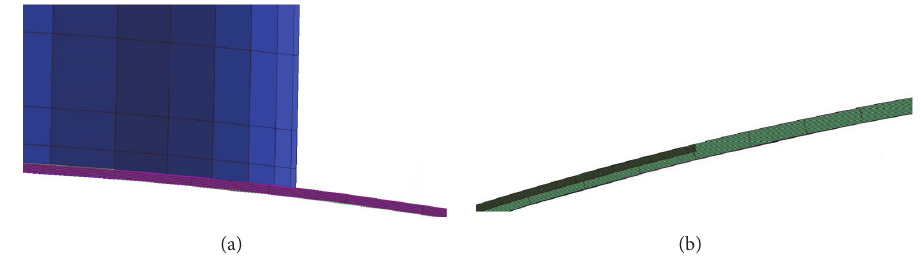
Figure 4: The local grid of (a) the plain gas film and (b) the herringbone groove gas film.